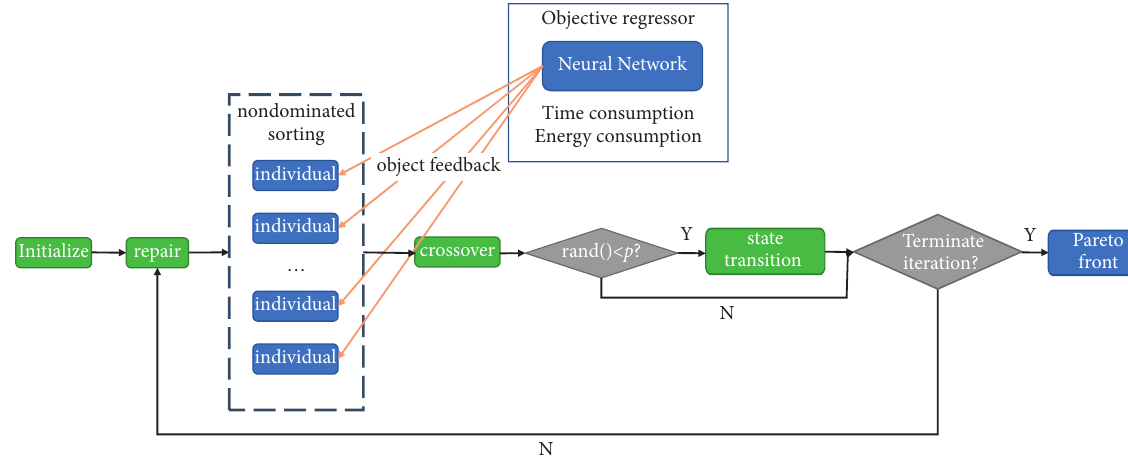
Figure 2: Flowchart of the proposed framework.